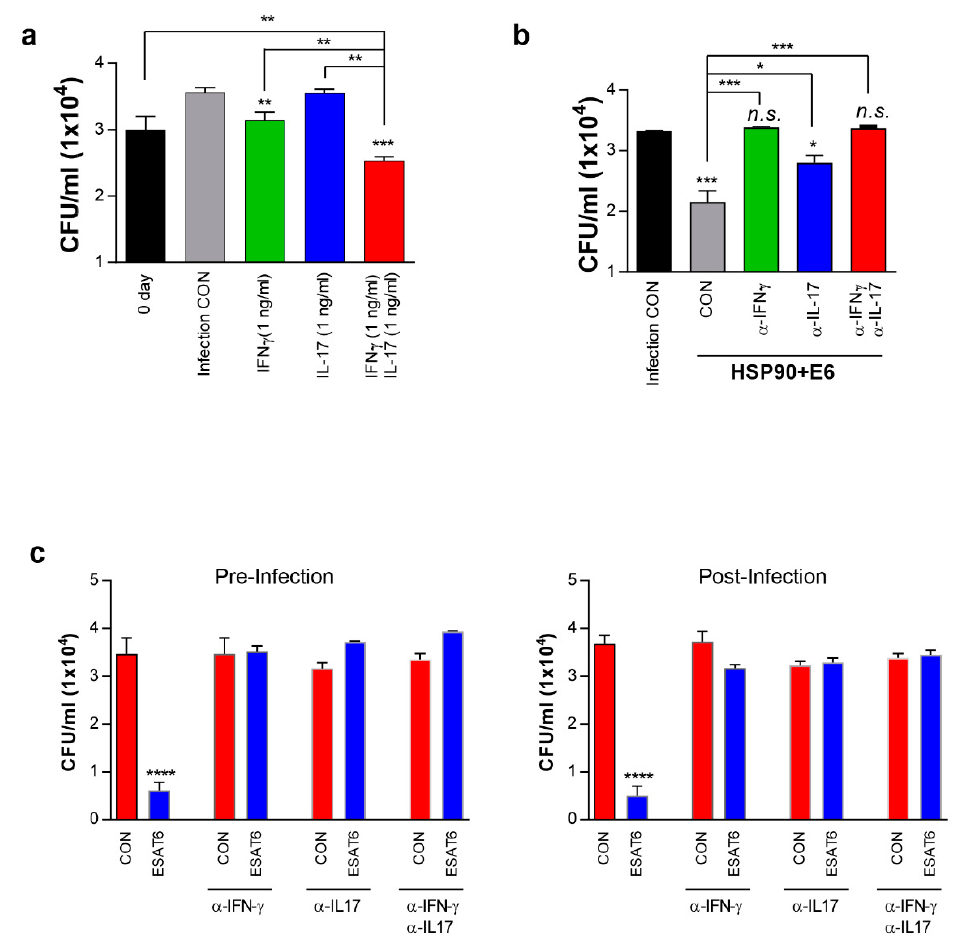
Figure 7. Synergistic inhibition of intracellular Mtb growth in macrophages by Th1 / Th17-induced responses. ( a ) Mtb-infected bone marrow-derived macrophages (BMDMs) were treated with IFN- γ (1 ng / mL), IL-17 (1 ng / mL), or both (1 ng / mL each) for 3 days. Intracellular Mtb growth in the BMDMs was determined at time point 0 days and 3 days after cytokine treatment. Data are the mean ± SD ( n = 3); * p < 0.05, ** p < 0.01, or *** p < 0.001. n.s. : no significant di ff erence. ( b ) T-cells activated co-cultured with Mtb-infected BMDMs in the presence or absence of neutralising antibody (anti-IFN- γ or anti-IL-17). Intracellular Mtb growth in BMDMs was determined after 3 days of co-culture, with or without T-cells (control). Data are the mean ± SEM (n = 3). ( c ) BMDMs were treated with supernatants of ESAT-6-re-stimulated HSP90-E6-vaccinated lung cells in the presence or absence of anti-IFN- γ or anti-IL-17 for 3 days. Intracellular Mtb growth in the BMDMs was determined after 3 days. Data